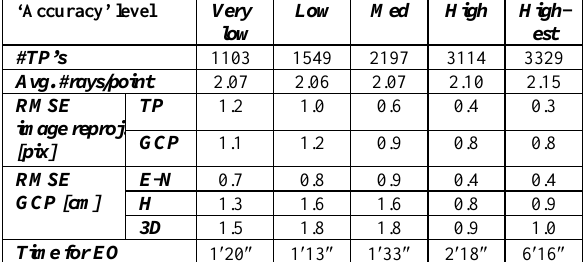
Table 1. Statistic on the computation of EO of ‘Test block’ using different configurations for EO (‘Image alignment’) in APP.